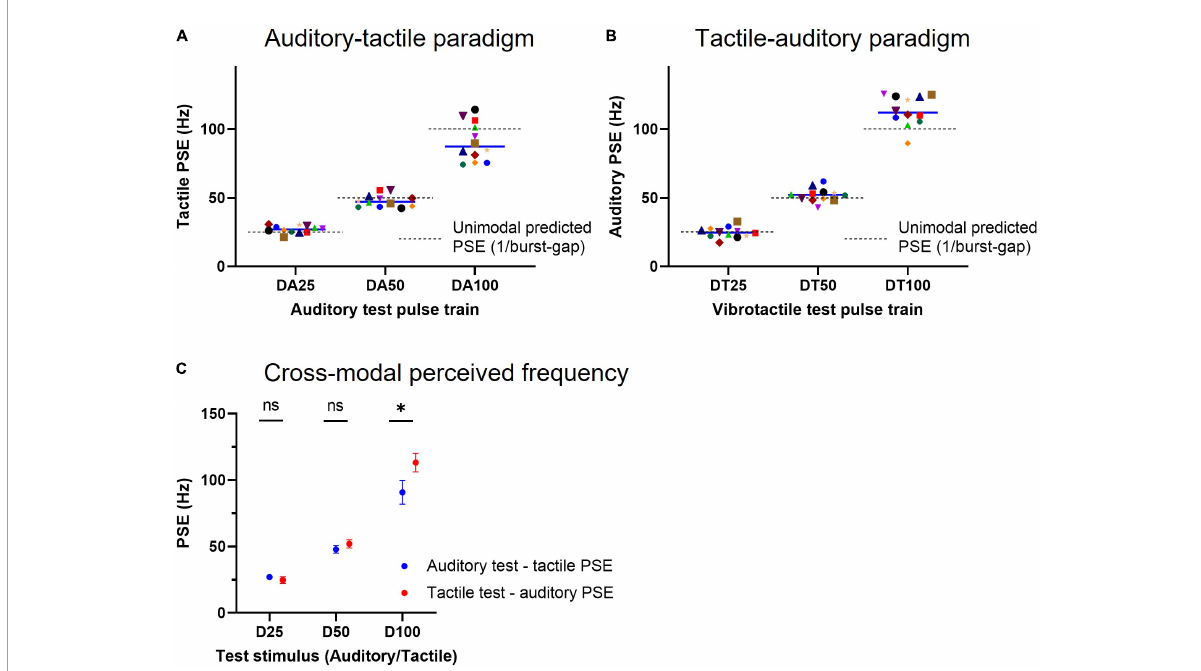
FIGURE6 Cross-modal equivalent frequency for acoustic and tactile doublet-burst pulse trains. (A) Individual subject tactile PSEs obtained for acoustic test pulse trains schematically depicted in Figure 2A (Auditory-tactile paradigm). A tactile point of subjective equality (PSE) represents the frequency of a vibrotactile pulse train that is equally likely to be judged higher or lower than the acoustic test stimulus, indicating an equivalent frequency for a given acoustic train. Each solid line indicates median PSE ( n = 12) values for test trains, while the dashed lines represent unimodal (i.e., test and comparisons from the same sensory modality) predicted PSEs estimated by the burst-gap model (1/burst-gap). (B) Individual subject auditory PSEs for vibrotactile test pulse trains shown in Figure 2A (Tactile-auditory paradigm), conventions as in panel (A) . (C) Cross-modal mean equivalent frequencies ( n = 12) for both auditory and tactile pulse trains that are identical. * represents p < 0.05 and error bars denote ± 95%